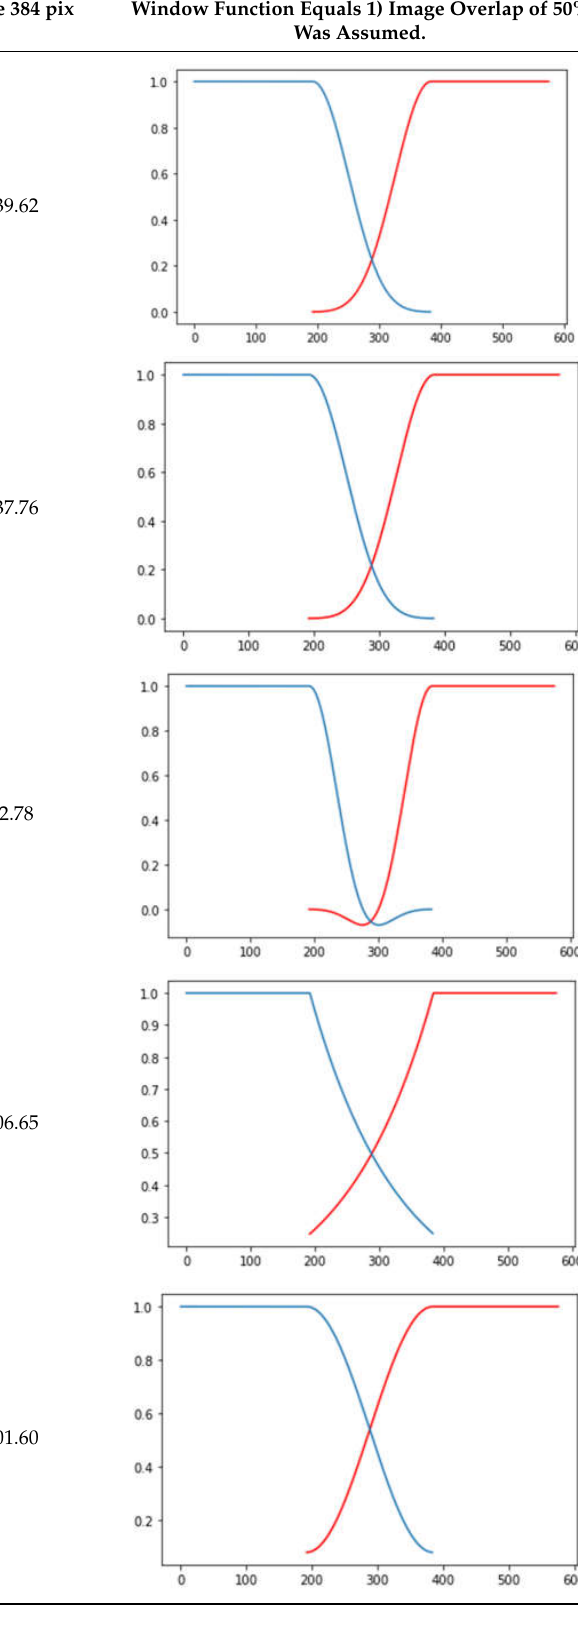
Figure (the Modification, When in Non-Overlapping Surface for Areas, i.e., on the External Edges, the Value of the Image 384 pix Window Function Equals 1) Image Overlap of 50% Was